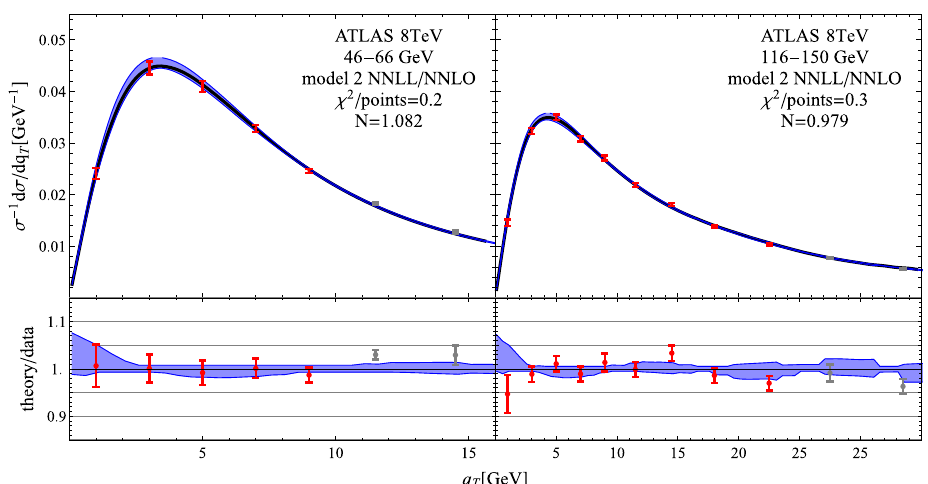
Fig. 13 The comparison of the data for Drell–Yan reaction collected at ATLAS to the fit of model 2 at NNLL/NNLO. Red data points are those which included in the fit (i.e. with δ T < 0 . 2). Gray data points are